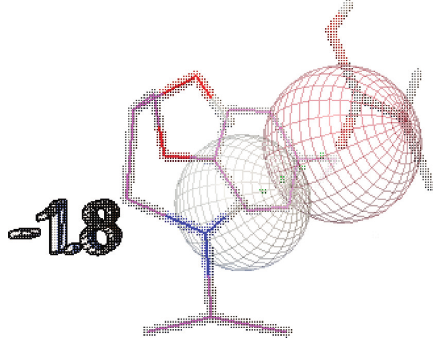
Figure 2: Interaction between atenolol and